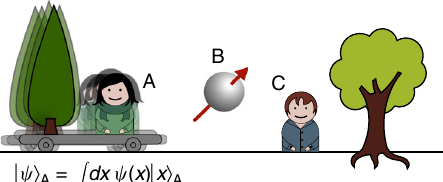
Fig. 1 Illustration of the notion of quantum reference frames. Two quantum reference frames A and C and quantum system B. The reference frames A and C are pictorially represented as two laboratories equipped with their own instruments. In a realistic situation, however, the system A could be an atom, B a photon and C a laboratory (or another atom). The reference frame associated to A is in a superposition of positions as observed from the laboratory C (the superposition is illustrated by the fuzziness of laboratory A). Given the quantum states of A and B relative to the reference frame of C, what are the states of B and C as de fi ned with respect to the reference frame of